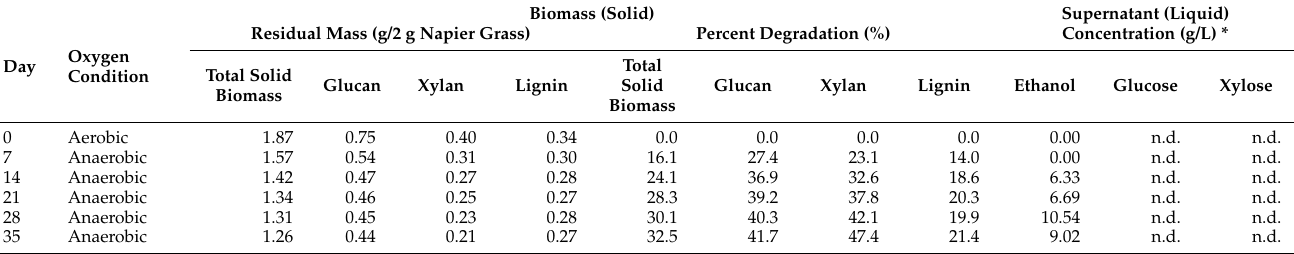
Figure 5. ( A ) Compositional changes and ( B ) product formation during the integrated biodelignification and consolidated bioprocessing of Napier grass by F. moniliforme BIOTECH 3170. Table 3. Compositional changes and product formation during the integrated biodelignification and CBP of Napier grass.